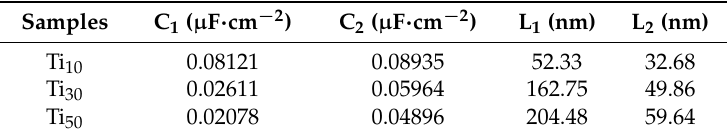
Table 5. Capacitance and thickness of porous outer layer and barrier inner layer for titanium anodized films formed under different